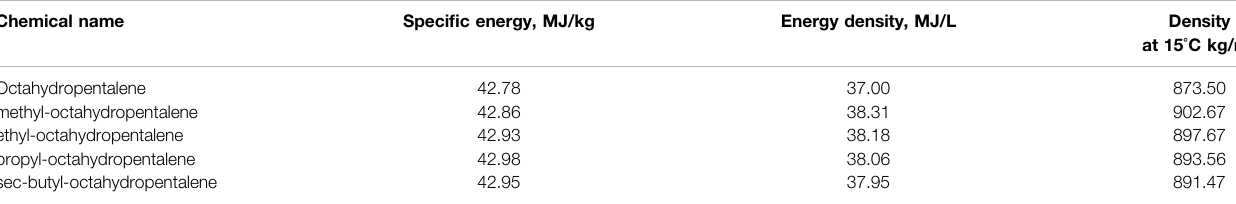
TABLE 4 | Physical properties of octahydropentalene and its derivatives analyzed in this work. Chemical